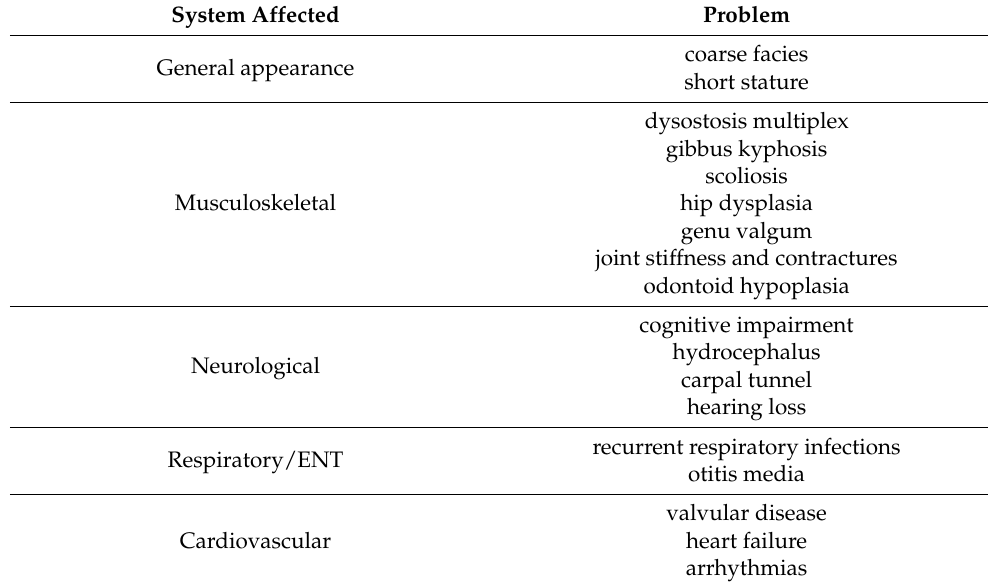
Table 1. Characteristic clinical MPS 1